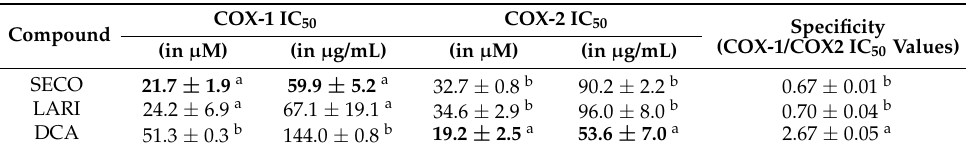
Table 5. IC 50 ( µ M) values for COX inhibition by lignans and neolignan accumulated in L. grandiflorum in vitro cultures.